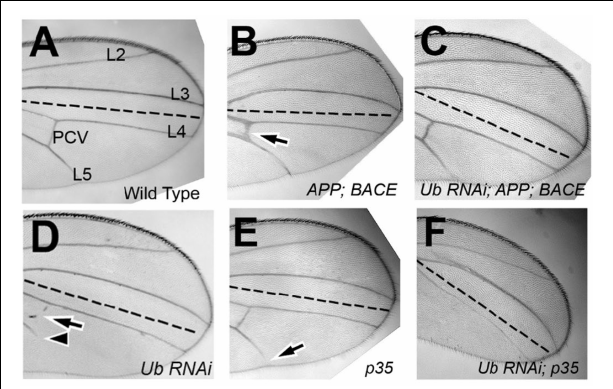
FIGURE 1 | Drosophila ubqn genetically interacts with human APP and BACE in the wing. All wings are anterior up, distal right, same magnification. All wings express UAS constructs in the posterior compartment only (as driven by engrailed:Gal4 ). UAS constructs are listed in the bottom right of each panel. Posterior compartments are depicted below the dotted line in each panel. (A) Representation of a wild type wing where UAS:GFP is expressed. Longitudinal wing veins L2-L5 are depicted, as is the posterior crossvein (PCV). (B) Representation of a wing where human APP and human BACE are co-expressed. Arrow shows extra vein and thickening of the PCV. (C) Representation of a wing where ubiquilin-1 RNAi (shUbqln1) is expressed with human APP and human BACE. Note the suppression of the extra/thick PCV. (D) Representation of a wing where ubiquilin-1 RNAi is expressed. Arrowhead shows loss of vein L5 material. Arrow shows loss of PCV. (E) Representation of a wing where UAS: p35 is expressed. Arrow shows loss of vein L5. (F) Representation of a wing where both ubiquilin-1 RNAi and p35 are co-expressed. Note the enhancement of vein loss in both the PCV and L5 tissue. Ub, Ubiquilin-1.